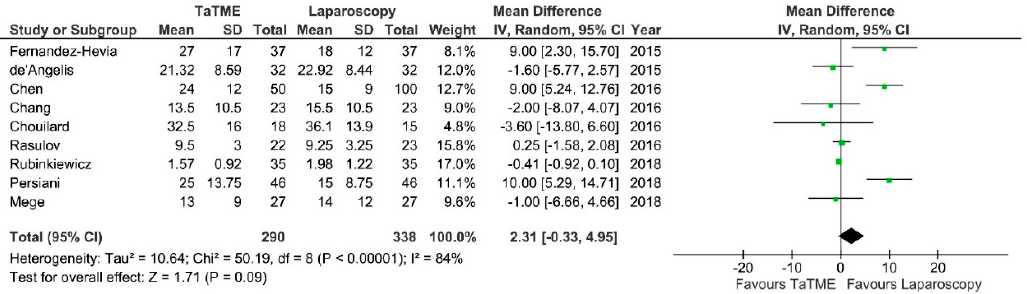
presented as diamond. Figure 10. Length of distal resection margin. CI—Confidence Interval; df—degrees of freedom; IV—